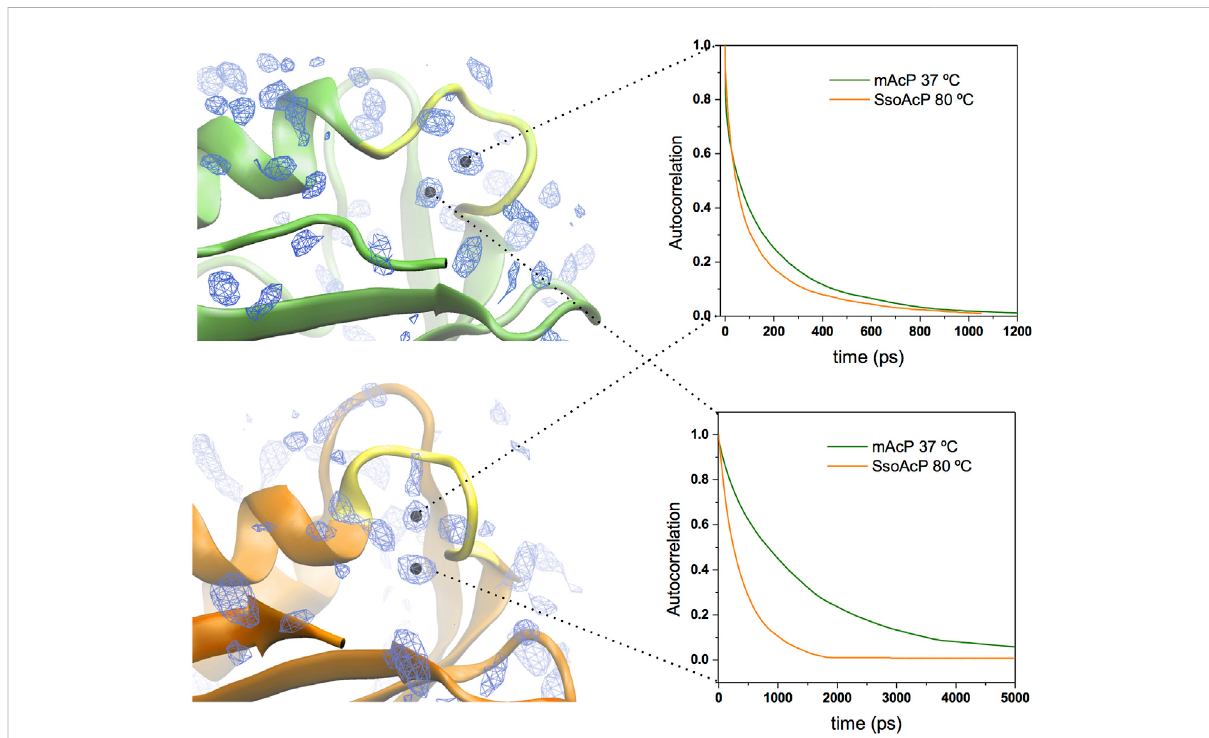
Structured waters inthe active site of mt AcP and Sso AcP . Twoconserved MDHS werefound in close contact with thephosphate binding loop inboth mtAcP and SsoAcP .WaterdensitymapisshownasbluecontourlineswiththetwoconservedMDHSmarkedwithblackdotsinthecentre. mt AcP (top)and SsoAcP (bottom) arerenderedas greenand orangeribbons,respectively, with thephosphate bindinglooprendered inyellowfor both systems. Autocorrelation functions of the waters in two MDHS are shown in the panels on the right (green and orange lines for mt AcP and Sso AcP , respectively). The resulting residence times are 311.5 ps ( mt AcP ) and 346.9 ps ( Sso AcP ) for the water in direct contact with the phosphate binding loop (top panel) and 4,297.5 ps ( mt AcP ) and 277.9 ps ( Sso AcP ) for the water interacting with Asn 21 (bottom panel) and participating to the catalytic mechanism Stefani et al.